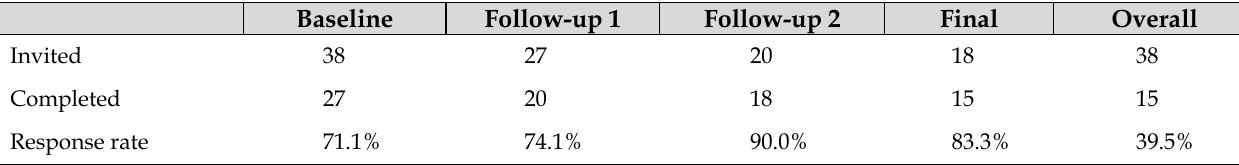
Table 1 Response rates by